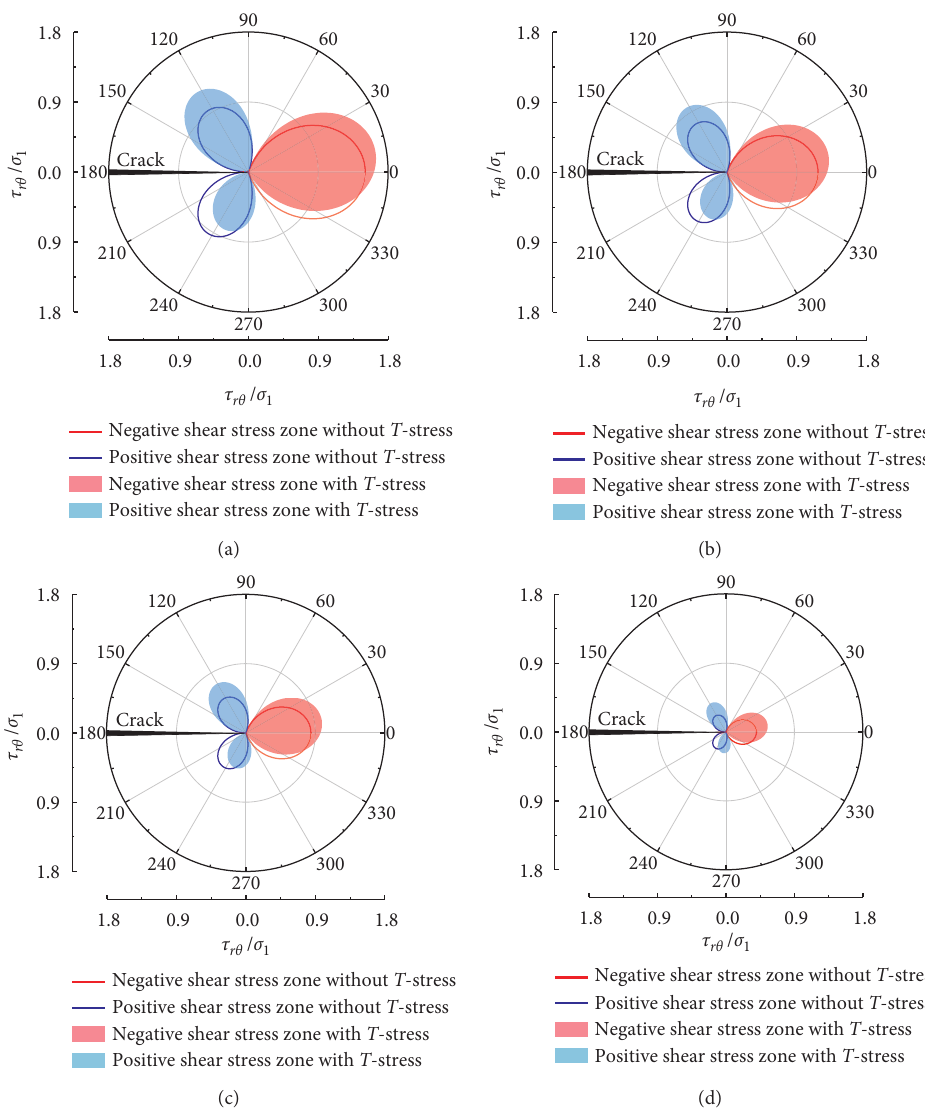
� 0.15, λ � 0. (b) μ � 0.15, λ � 0.15. (c) μ � 0.15,